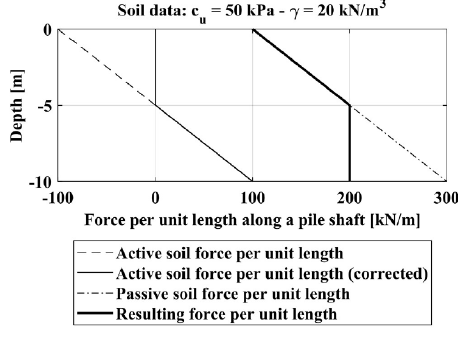
Figure 7. Soil pressure profile.